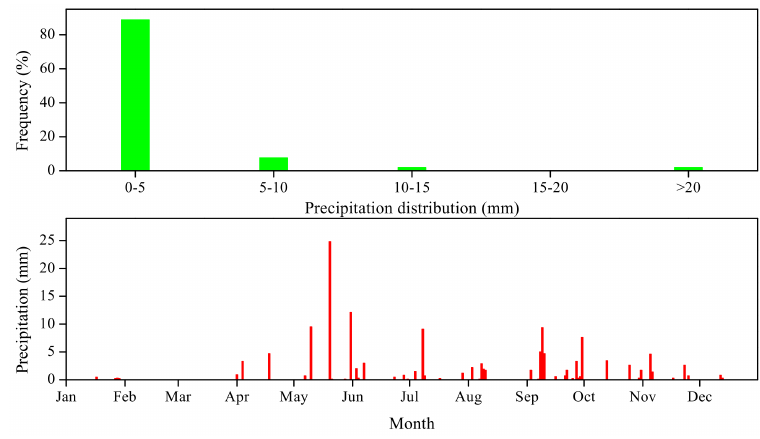
Figure 1. Precipitation and precipitation distribution in